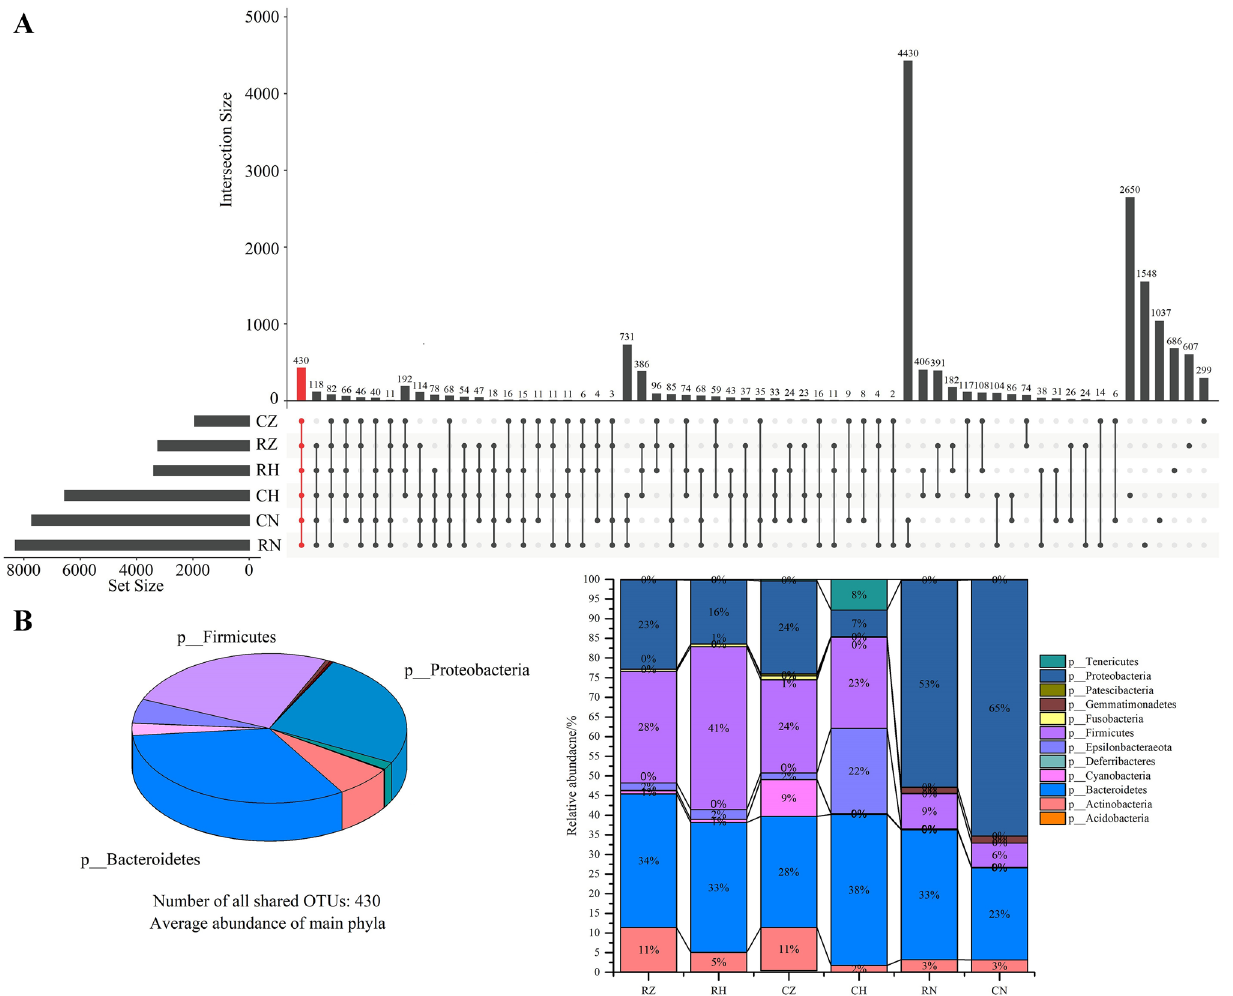
Figure 1. UpSet plot analysis at the operational taxonomic unit (OTU) level in all groups ( A ) and the distribution of shared OTUs at phylum level in all groups ( B